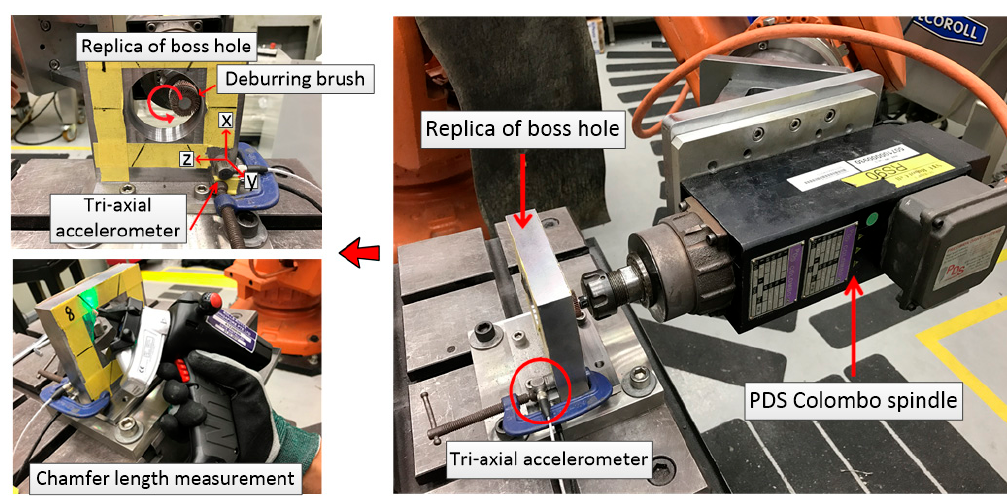
Figure 6. The accelerometer setup and chamfer length measurement process.